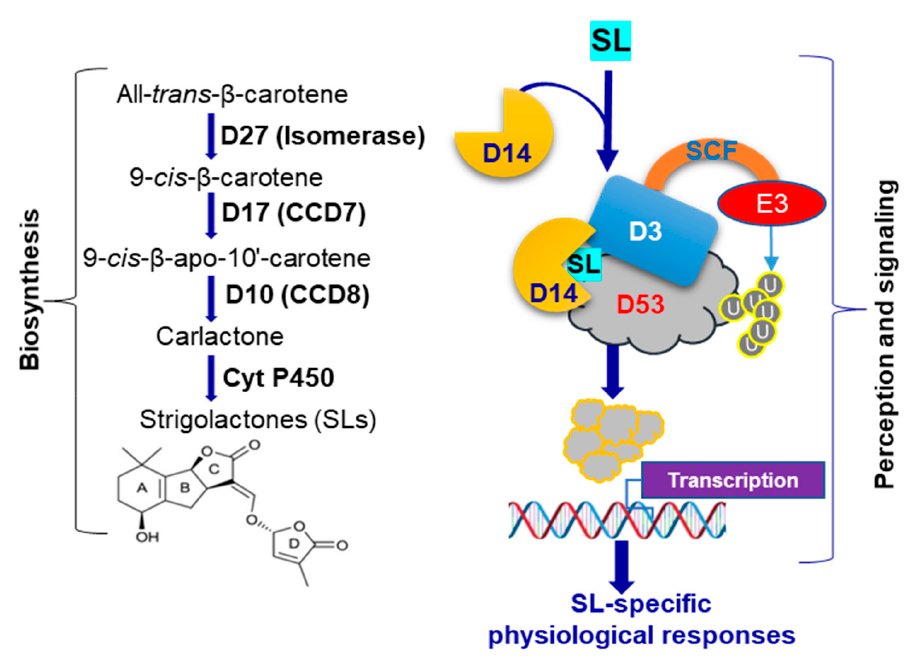
Figure 1. Biosynthesis and signaling of strigolactones (SLs) in rice. SLs are synthesized from all- trans - β -carotene by consecutive actions of β -carotene isomerase ( D27 ), carotenoid cleavage dioxygenase (CCD)7 ( D17 ), CCD8 ( D10 ) and cytochrome P450 (Cyt P450) proteins. SLs bind to receptor D14 followed by interaction with D3, leading to the formation of a Skp1-Cullin-F-box (SCF) D3 type of E3 ubiquitin ligase complex. D53 is ubiquitinated by this SCF-protein complex, which triggers proteasomal degradation of D53, resulting in SL signaling events for activation of various physiological functions in rice. E, ubiquitin ligase; U, ubiquitin.